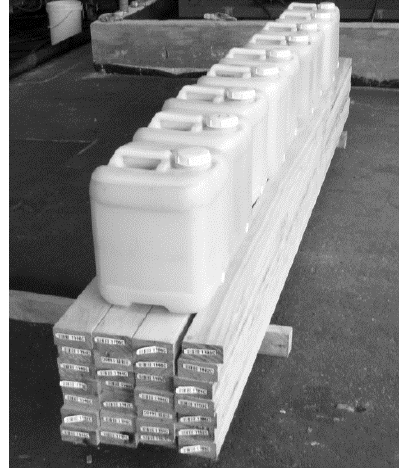
Figure 2. Result of a dewatering experiment using 0.105 m 3 of green radiata pine timber. The nine 20-litre containers atop the wood stack store the volume of sap recovered from seven carbon dioxide supercritical fluid to gas phase-change cycles. The wood stack was allowed to passively dry over 2 days from 40% moisture content to ambient equilibrium moisture content, < ca. 20%. Photo: R. Franich (13 August